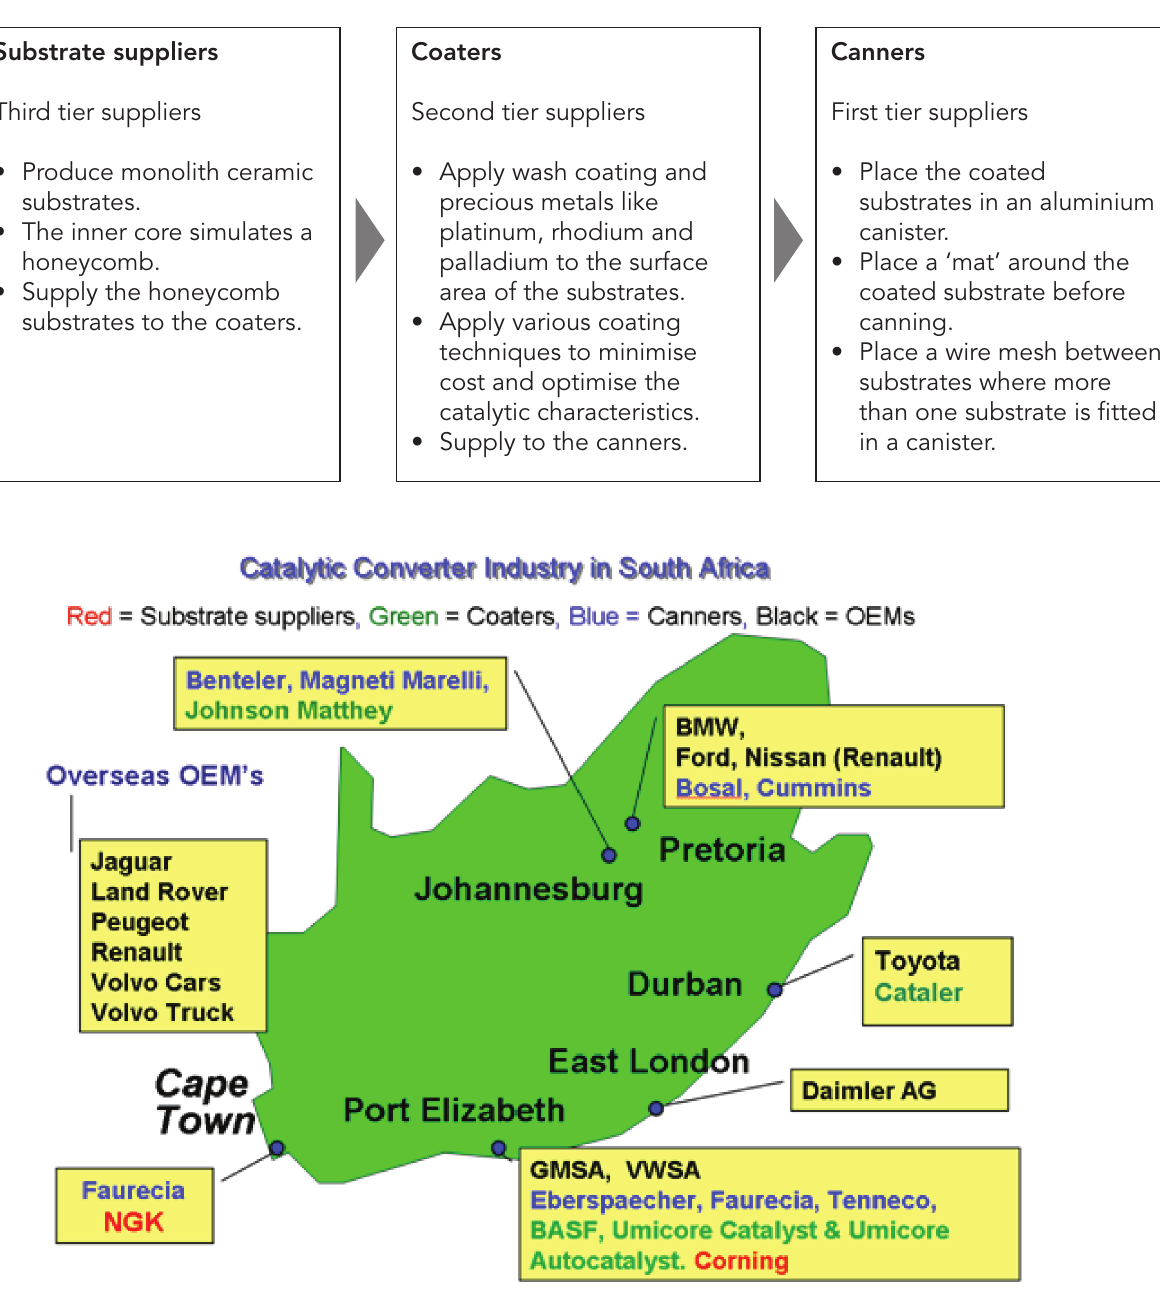
Figure 4: Geographic location of the catalytic converter supply chain in South Africa (source: Anonymous 3, NGK Ceramics South Africa: 2009,